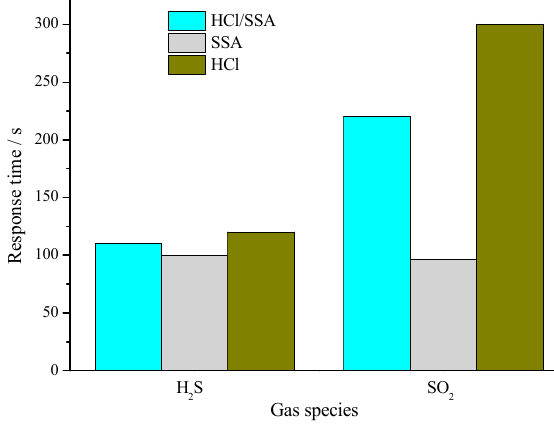
Figure 14. Response time of PANI-HCl and PANI-HCl/SSA sensor to H 2 S and SO 2 of 100 μ L/L.